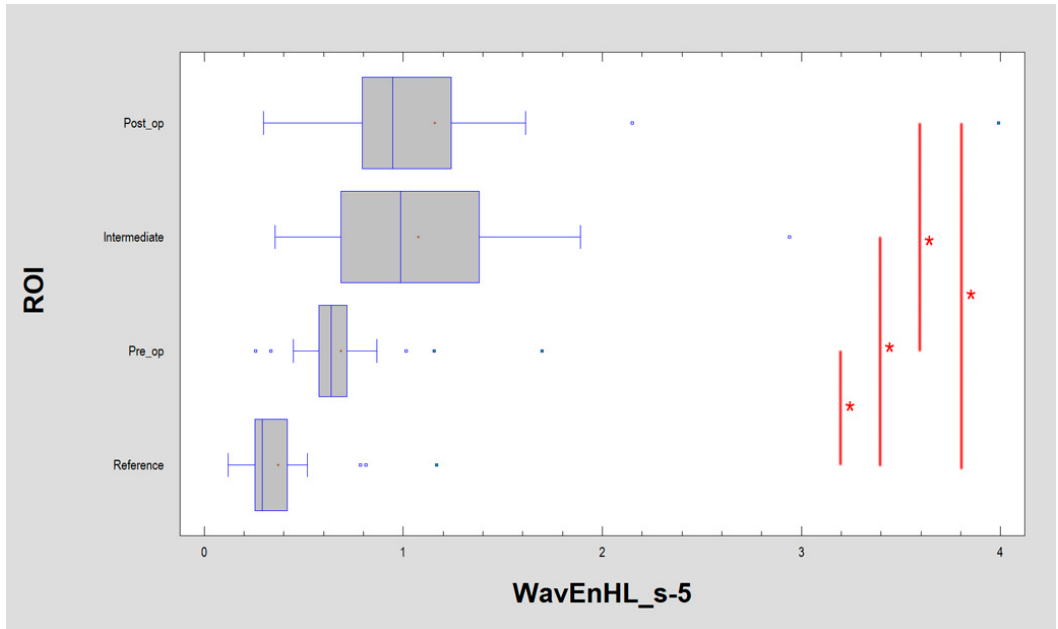
Figure 8. Recognition of large structures in the field of vision (discrete wavelet transform) revealed in the image of the buccal mucosa after surgery, representing a difference from the reference image. These differences consist of the presence of oval fields with a different structure than normal mucous membrane. + average, blue vertical line indicates median, * significant difference ( p < 0.05). Table 1. Digital texture analysis of oral mucosa photographic images after leukoplakia treatment by Er:YAG laser (average ± standard deviations). Abbreviations: ROI—region of interest, i.e., sample of image, KW—Kruskal–Wallis.